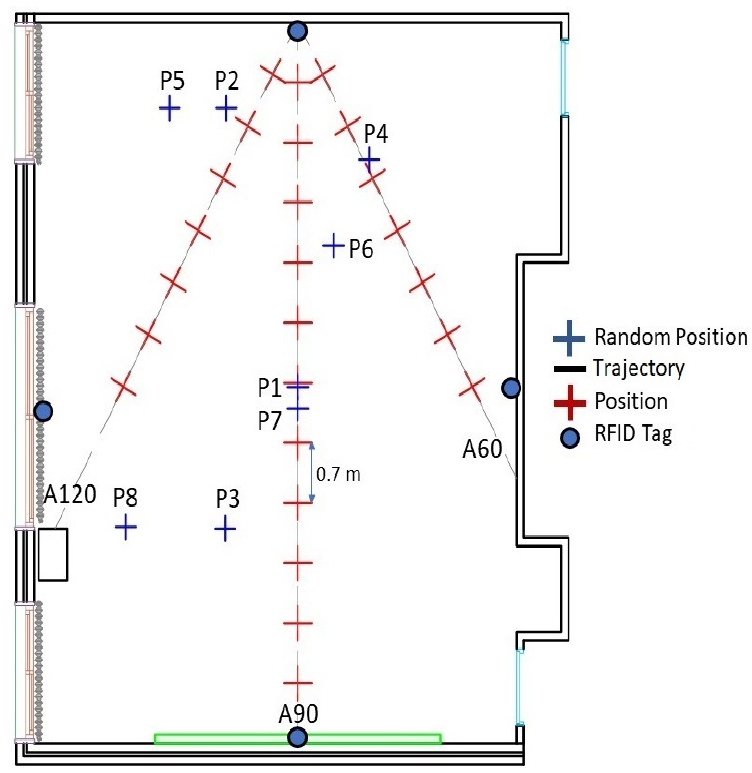
Figure 9. Two-dimensional configuration of the eight random positions.